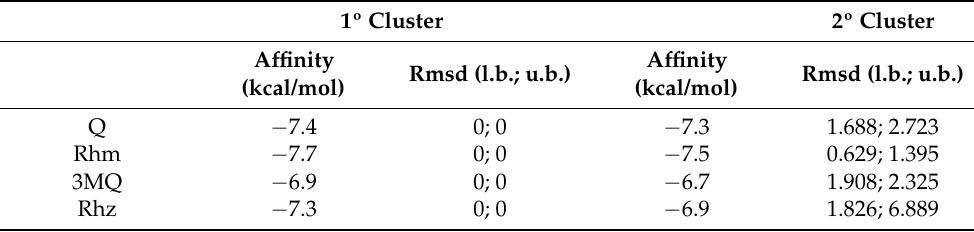
Table 5. Binding free energy (affinity) and rmsd values of BthTX-II with each quercetin derivative. 1º Cluster